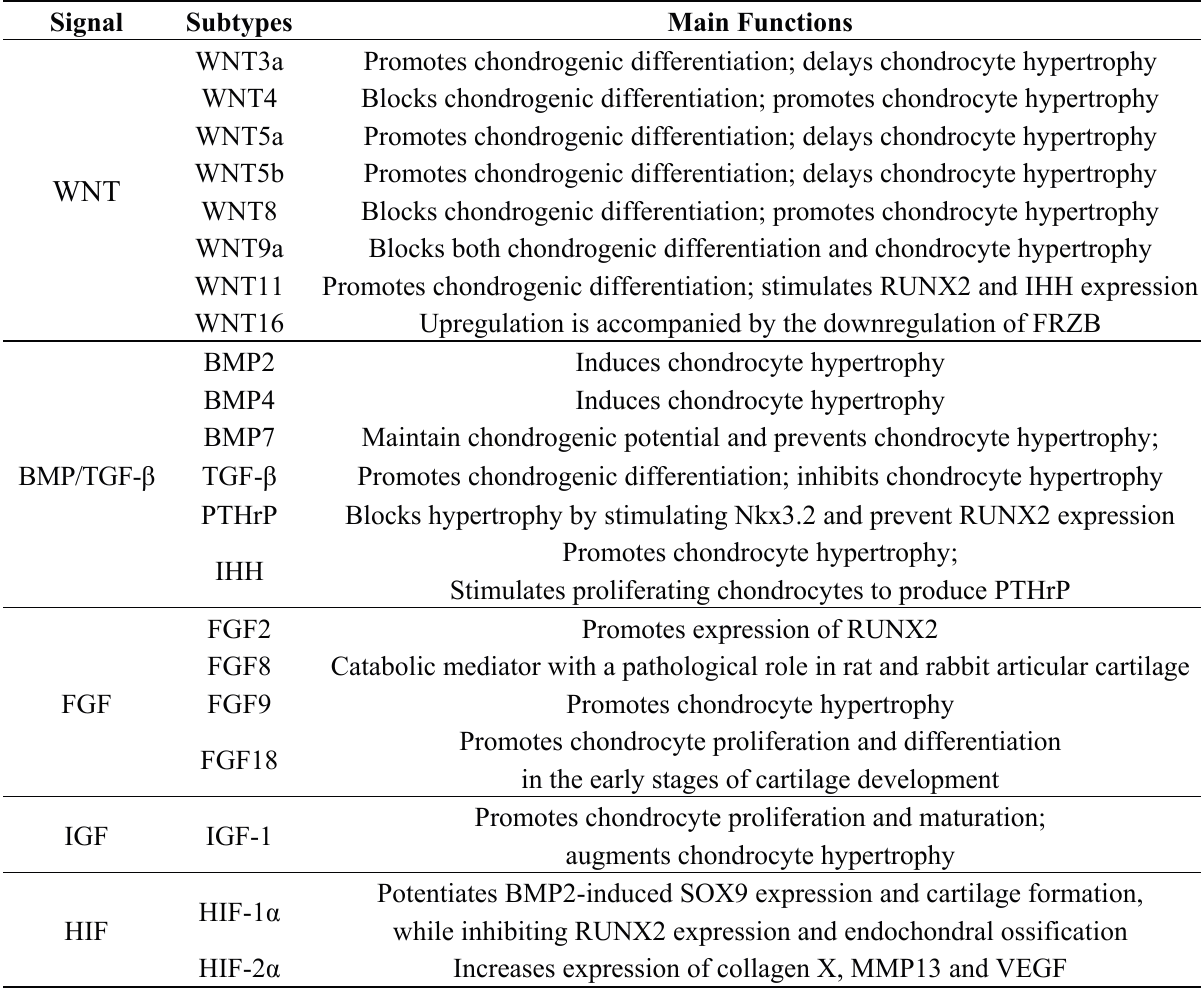
Table 1. The subtypes involved in multiple signal pathways (WNT, BMP/TGF β , PTHrP, IHH, FGF, IGF and HIF) and their main functions in the regulation of chondrocyte differentiation and